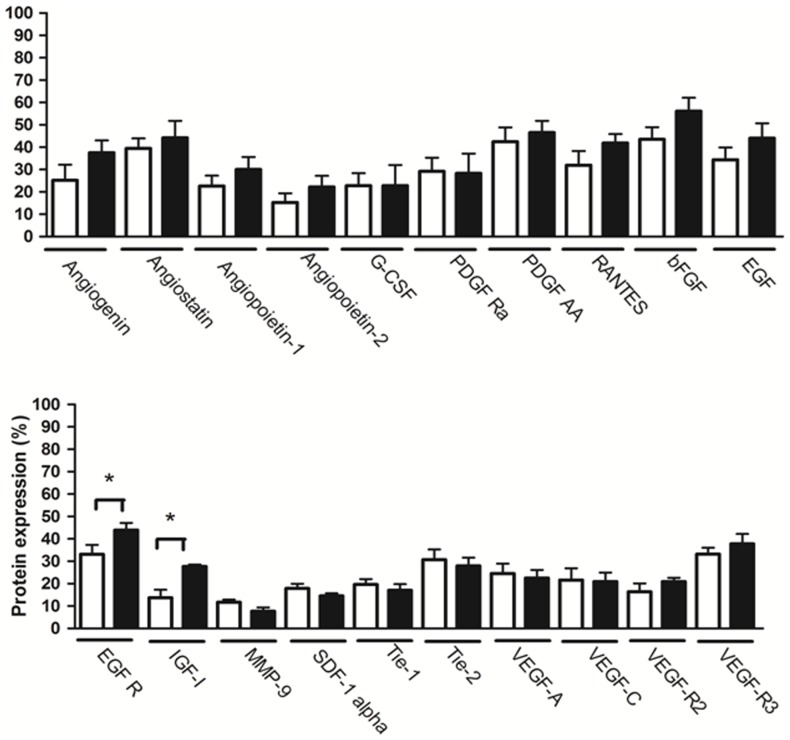
Comparison between proteins expression in mammary tumor in animals treated with melatonin or vehicle.White column  =  vehicle treatment; Black column  =  melatonin treatment. Data are shown as mean ± S.D. *p<0.05, vs. Control.